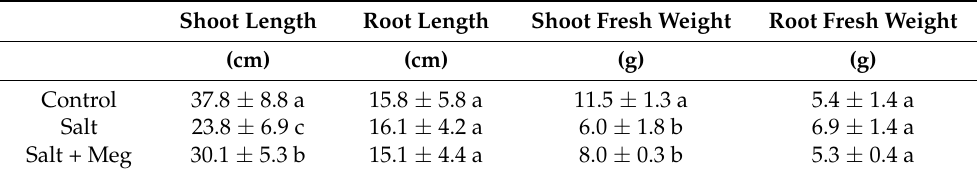
Table 1. Shoot and root lengths, shoot and root fresh weight of maize seedling controls, and grown with NaCl alone, and NaCl with the biostimulant (i.e., Control, Salt, Salt + Meg, respectively). Shoot Length Root Length Shoot Fresh Weight